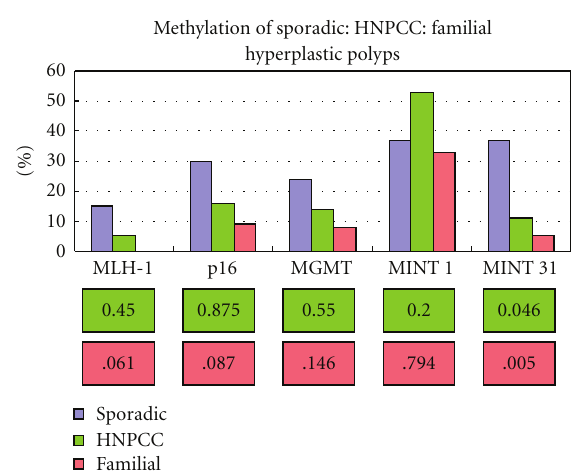
Figure 3: Methylation of hyperplastic polyps, sporadic: HNPCC: familial. P values are in pink boxes. No significant di ff erences were demonstrated between the sporadic and HNPCC groups. For MINT 31 there was a significant di ff erence between the familial and sporadic group. For MLH-1 (MSP), p16 INK4a and MGMT the di ff erence between the familial and sporadic group nearly reached significance.